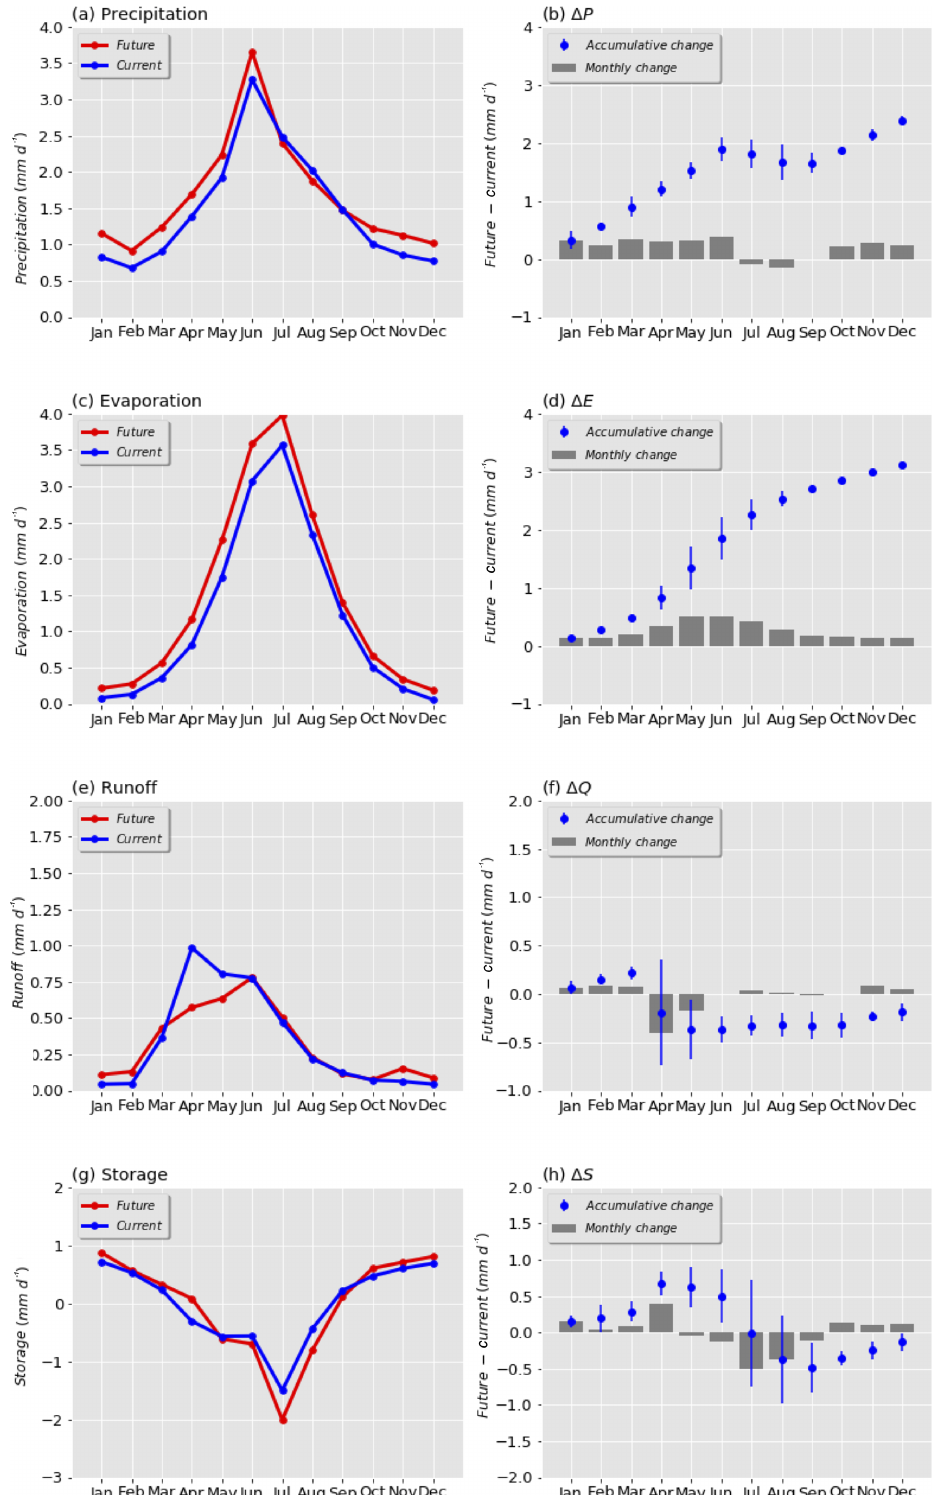
Figure 5. The same as in Fig. 4, except for